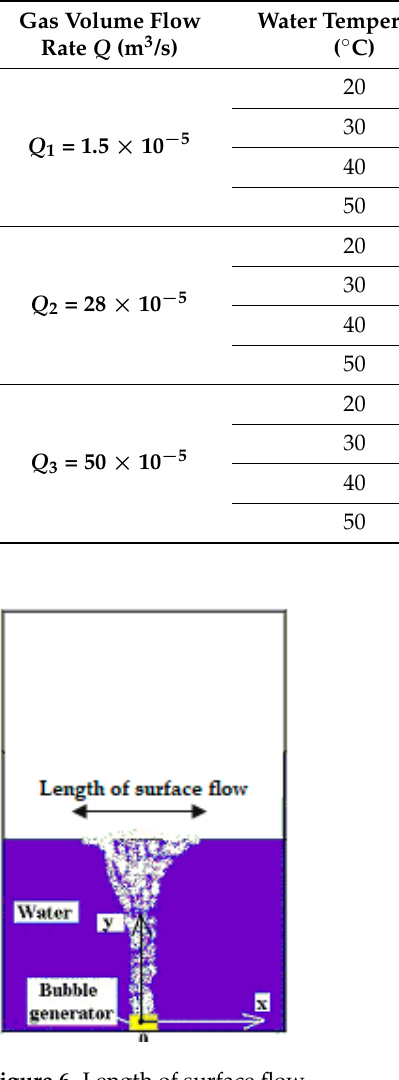
Figure 6. Length of surface flow.